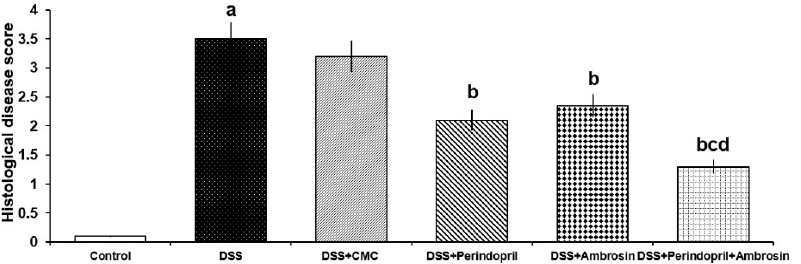
Figure 6. Effect of perindopril with or without ambrosin on the histological disease score in mice treated with DSS (Mean ± SD); where “a” denotes significant vs the control group ( p -value less than 0.05); “b” denotes significant vs DSS group ( p -value less than 0.05); “c” denotes significant vs DSS + perindopril group ( p -value less than 0.05); “d” denotes significant vs DSS + ambrosin group ( p -value less than 0.05).